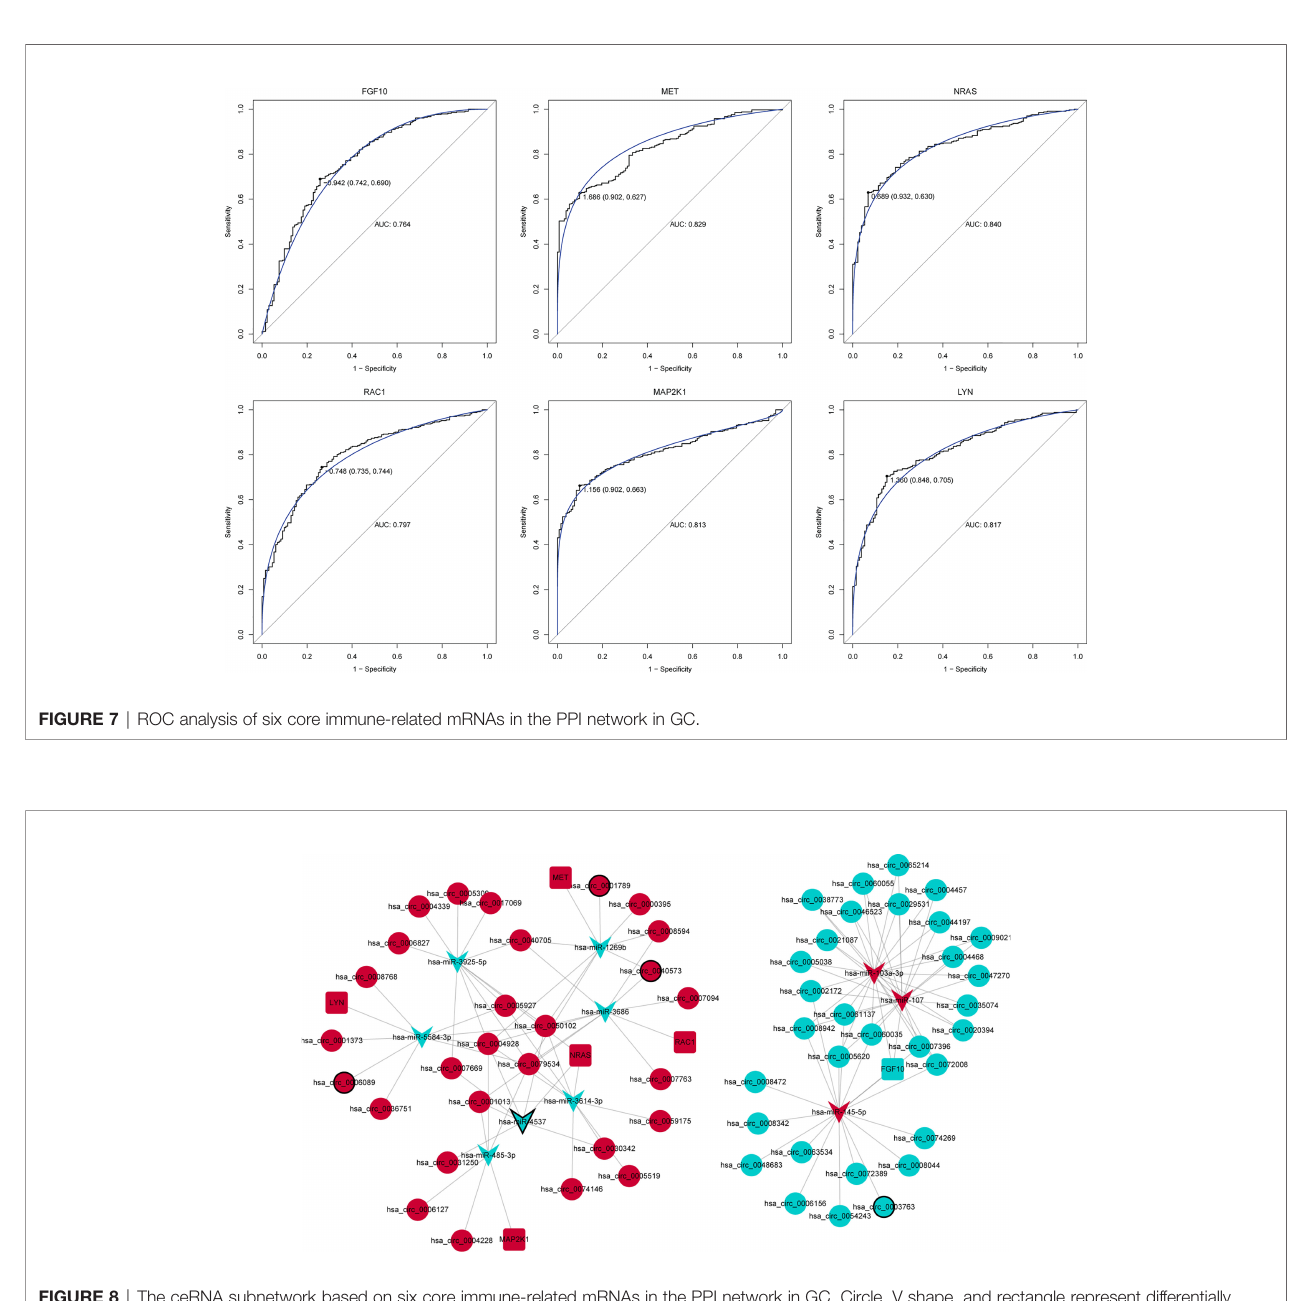
FIGURE 8 | The ceRNA subnetwork based on six core immune-related mRNAs in the PPI network in GC. Circle, V shape, and rectangle represent differentially expressed circRNA, miRNA, and mRNA, respectively. Red and green represent upregulation and downregulation, respectively. The black border represents the top 10 up/downregulated